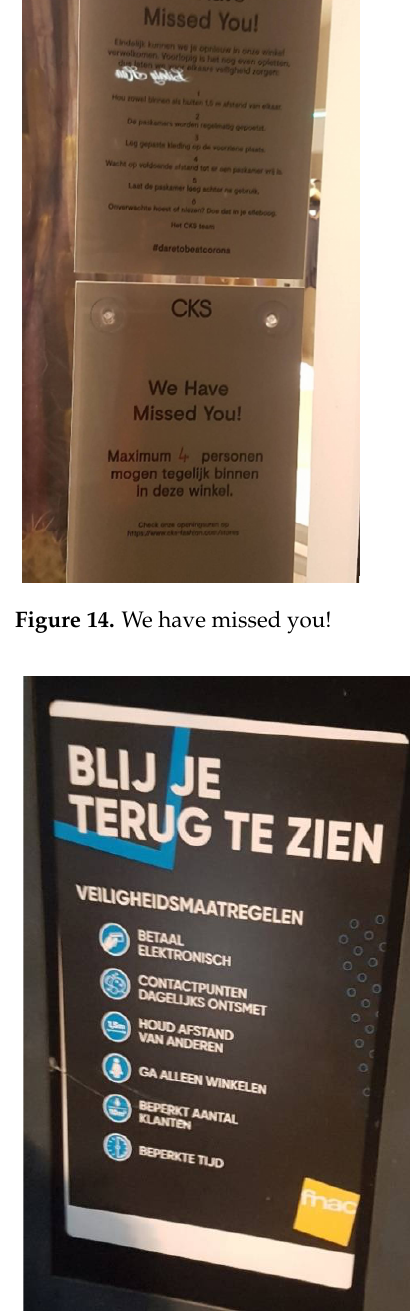
Figure 15. Happy to see you again.